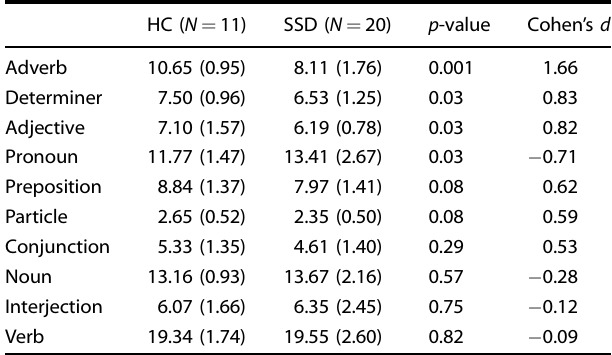
results. Figure 2 shows the average BERT embedding difference between the original interviewer prompt and the participant ’ s response sentence, varying by distance from the original prompt. Modeling the trajectories for embedding distance, we found the intercept for SSD (0.260, 95% CI [0.257, 0.263]) was signi fi cantly higher than of HC (0.247, 95% CI [0.242 – 0.252]), suggesting that